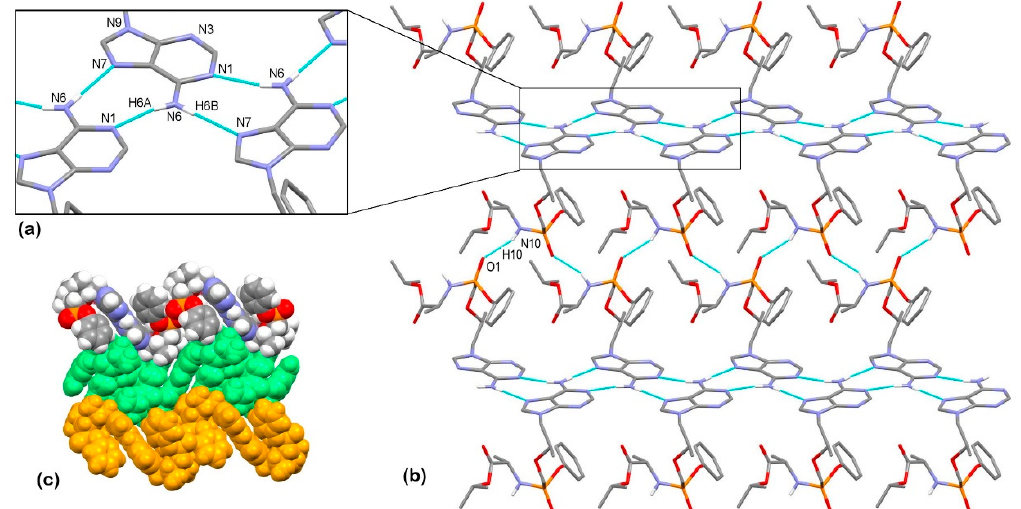
Figure 4. Hydrogen bond architecture in the TA crystal. ( a ) The interactions involving adenine moieties; ( b ) Wavy layered structure along the b axis; ( c ) Packing of layers along the c axis (arbitrary colors). Hydrogen bonds are drawn with dashed blue lines. Hydrogen atoms not involved in the shown motif have been omitted for clarity.